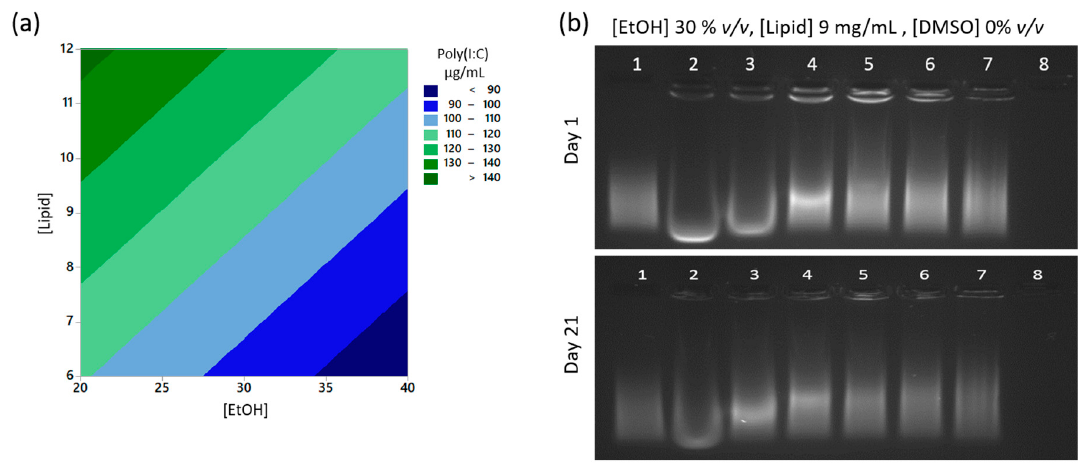
Figure 3. Poly(I:C) (125 µ g / mL) in samples treated with 1% w / v SDS or untreated was quantified with the Ribogreen assay. Poly(I:C) could not be detected in untreated samples. ( a ) RSM model of